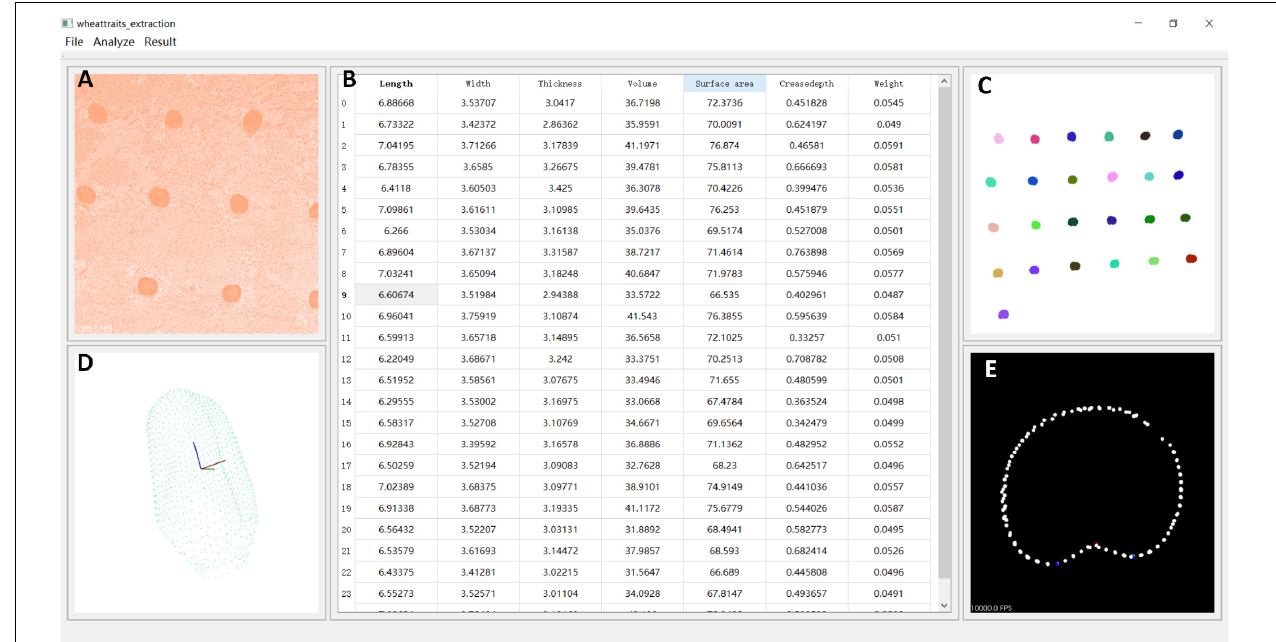
FIGURE 6 | Wheat 3D traits extraction software. (A) Original point clouds. (B) Grain traits and weight prediction. (C) Grain segmentation results. (D) Single grain point clouds. (E) Ventral sulcus slicing